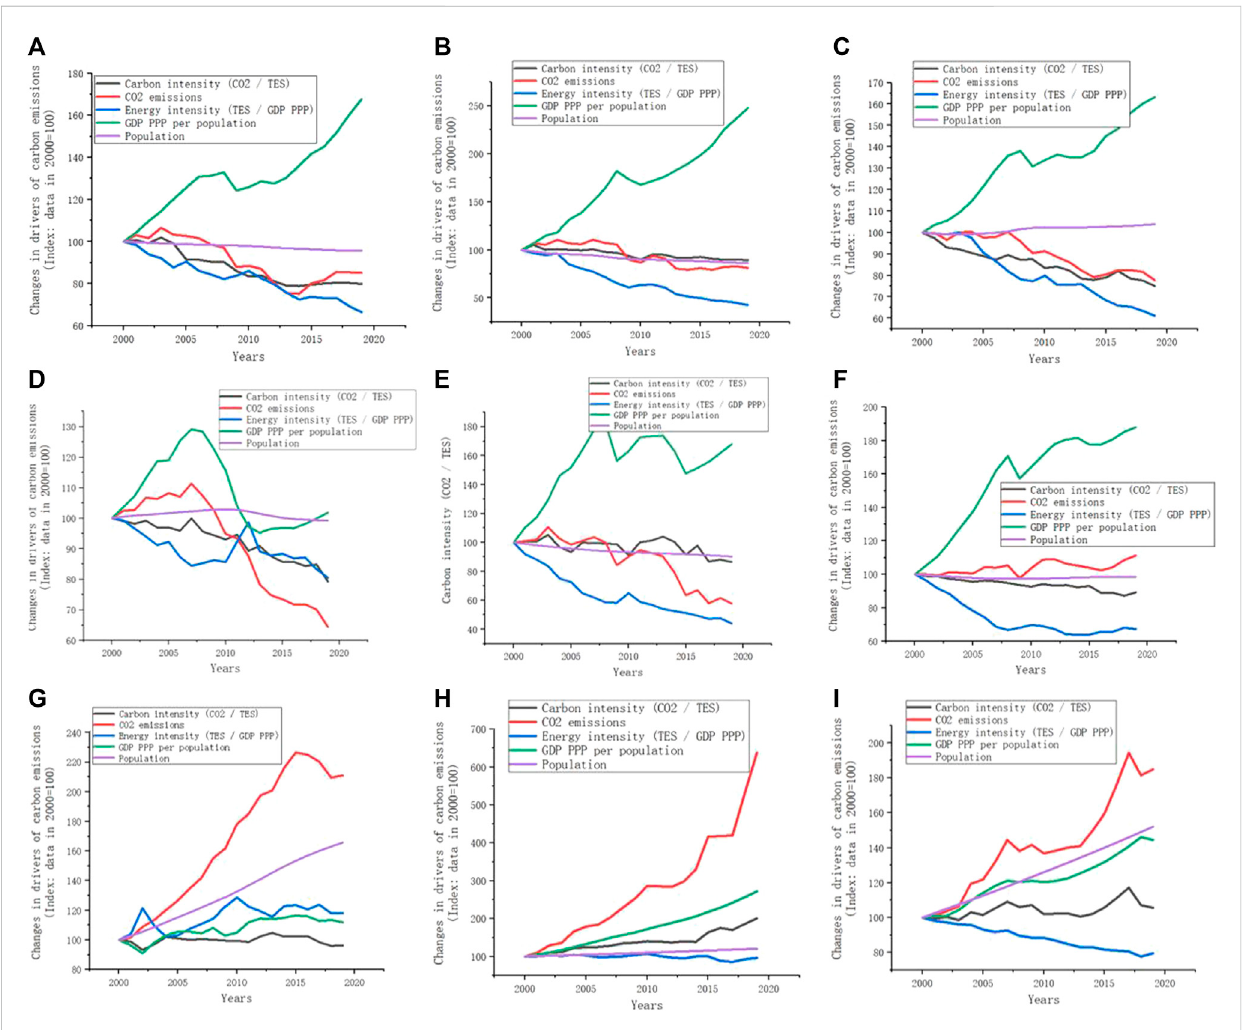
ThecarbonemissionsdriversincountriesalongtheBeltandRoad. (A) Hungary; (B) Romania; (C) CzechRepublic; (D) Greece; (E) Ukraine; (F) Russian Federation; (G) Saudi Arabia; (H) Pakistan. (I)